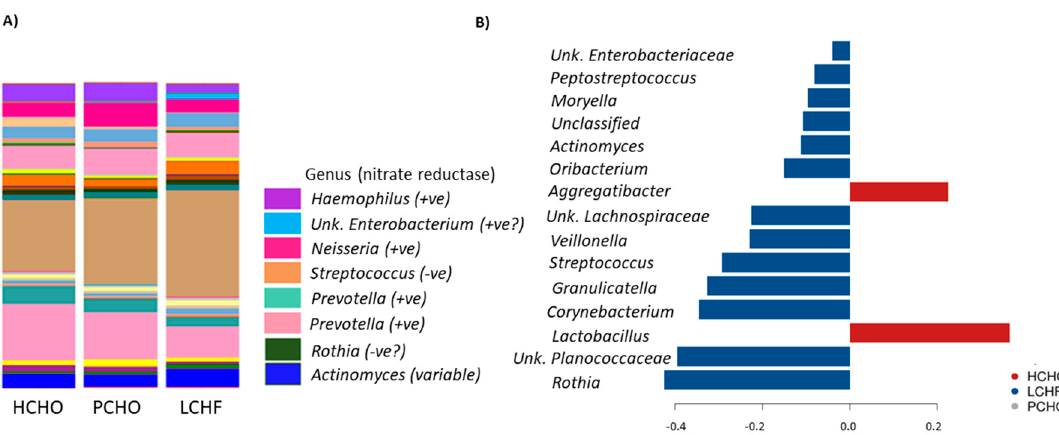
Figure 5. Oral microbiome profiles (genus-level) of athletes consuming either a high carbohydrate (HCHO), periodised carbohydrate (PCHO) or a low-carbohydrate high-fat diet (LCHF) after the diet-training intervention where bar plots represent: ( A ) relative abundance of genera in saliva samples after dietary interventions and their inferred nitrate reductase activity; ( B ) microbial families associated with different diets as identified by sparse Partial Least Squares Discriminant Analysis (sPLS-DA).